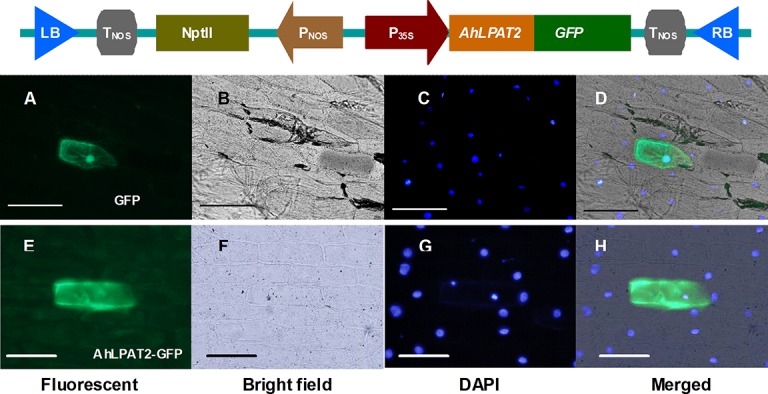
Subcellular Localization of the AhLPAT2–GFP Fusion Protein in Onion Epidermal Cells.The top panels show the expression vector containing AhLPAT2 and the GFP reporter gene. AhLPAT2 tagged with GFP in the C-terminus was inserted into the pEGFP vector between the KpnI and XmaI restriction sites. LB, left border; RB, right border; PNOS and TNOS are the promoter and polyadenylation signal of the nopaline synthase gene, respectively; NptII neomycin phosphotransferase II, CaMV 35S promoter. Bottom panels show the expression of GFP and AhLPAT2-GFP. (A) GFP fluorescence of onion epidermal cells expressing GFP. (B) Bright field image of (A). (C) Cell nuclei counterstained with DAPI. (D) Merged image of (A), (B) and (C). (E) GFP fluorescence of onion epidermal cells expressing AhLPAT2-GFP. (F) Bright field image of (E). (G) Cell nuclei counterstained with DAPI. (H) Merged image of (E), (F) and (G). Scale bars = 50 μm.